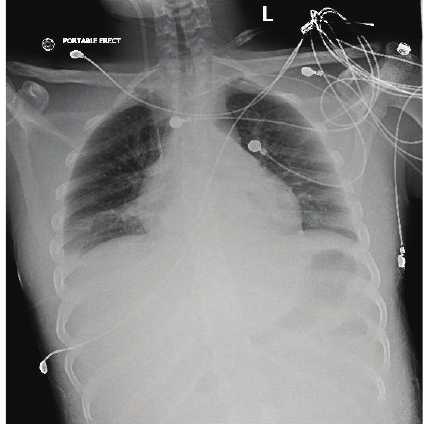
Figure 6: Triple loops snare used to retrieve catheter fragment.